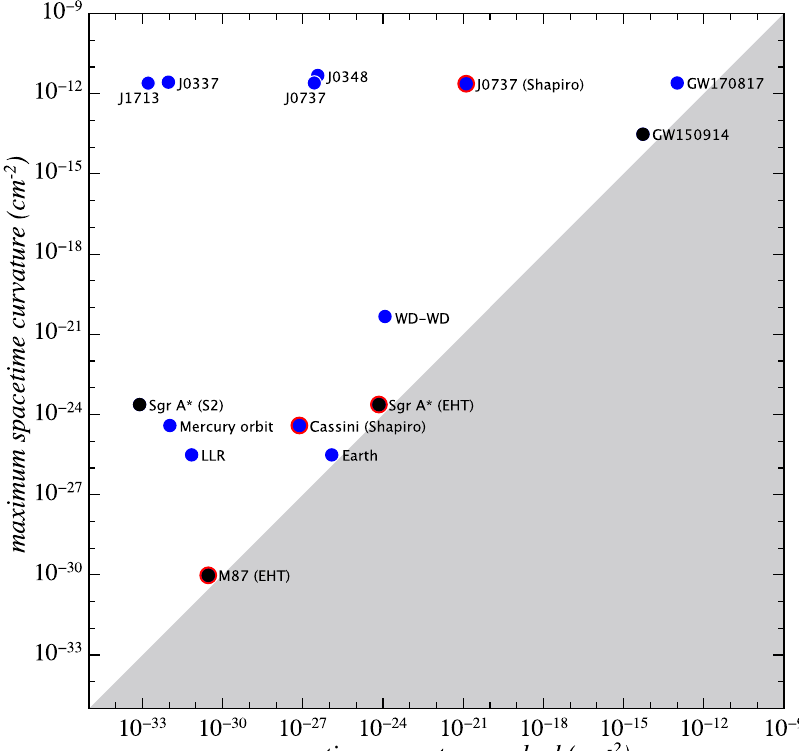
Figure 7. Comparison of different gravity experiments. On the x -axis is the spacetime curvature probed, for instance the curvature associated with the external mass at the location of the pulsar. The y -axis gives the maximum spacetime curvature in the system. The curvature is calculated as the square-root of the Kretschmann scalar R αβγδ R αβγδ (full contraction of the Riemann tensor). For material objects (blue) the maximum curvature is related to their compactness. For BHs (black) it is the